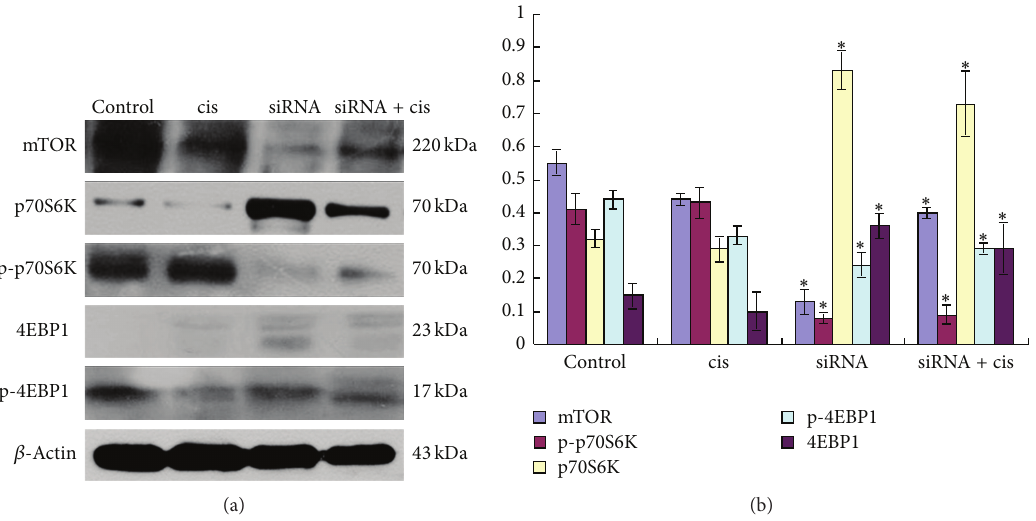
Figure 4: Protein expression of effectors in mTOR pathway of EC9706 xenografts treated with different ways. (a) Antibodies to mTOR, p70S6K, p-p70S6K, 4EBP1, and p-4EBP1, respectively. (b) Semiquantitative values of bands from three independently repeated experiments, which were statistically analyzed by densitometry using TotalLab 2.0 software, are expressed as means ± SD. Reduced expressions of mTOR, p-p70S6K, and p-4EBP1 and elevated expressions of p70S6K and 4EBP1 were observed in groups treated with mTOR siRNA and mTOR siRNA combined with cisplatin. 𝛽 -Actin was used as loading control. ∗ 𝑃 < 0.05 , compared to control group.